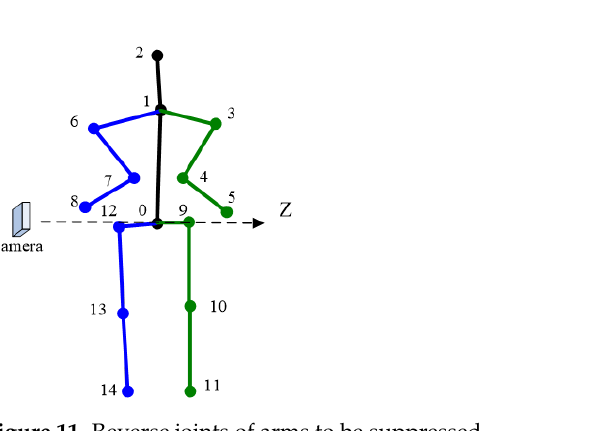
Figure 11. Reverse joints of arms to be suppressed.